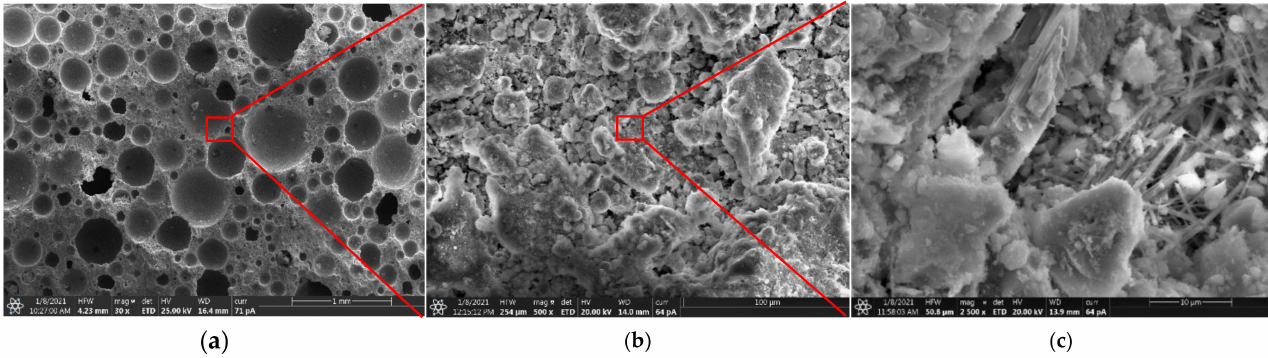
Figure 14. SE images of pore structure and hydration products foamed concrete: ( a ) magnification of 30 × ; ( b ) magnification of 500 × ; ( c ) magnification of 2500 × . The XRD patterns of foamed concrete with different LM–FA dosages are shown in Figure 15. The main crystalline phase was portlandite (Ca(OH) 2 ) after 28-day curing. Besides, calcium silicate hydrates (C-S-H), calcite (CaCO 3 ), unreacted dicalcium silicate (C 2 S), and tricalcium silicate (C 3 S) were also found in the samples. Replaced cement with 70% LM–FA, the diffraction intensity of calcite significantly increased, and that of portlandite was reduced. Mullite, one of the mineral phases of FA, was also found. The hydration of FA consumed a large amount of Ca(OH) 2 from cement hydration products and LM, thus resulting in an enhancement on the pozzolanic reaction of FA.